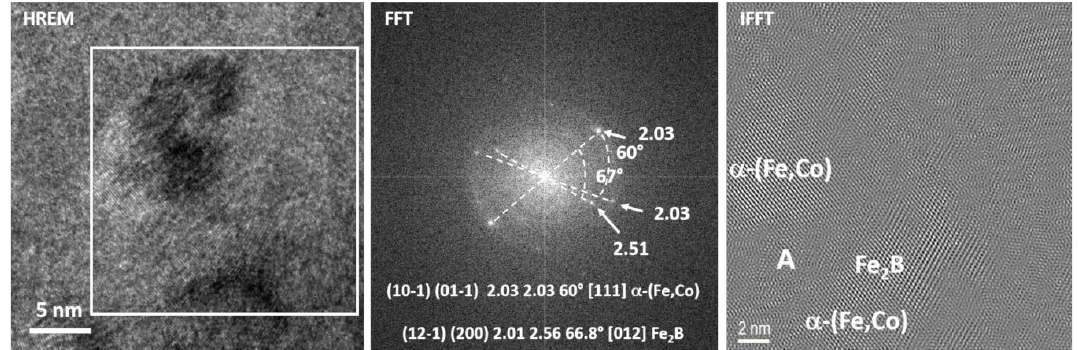
Figure 7. HREM, FFT, and IFFT images of the sample in situ heated up to a temperature of 500 °C with a heating rate of 200 °C/min.